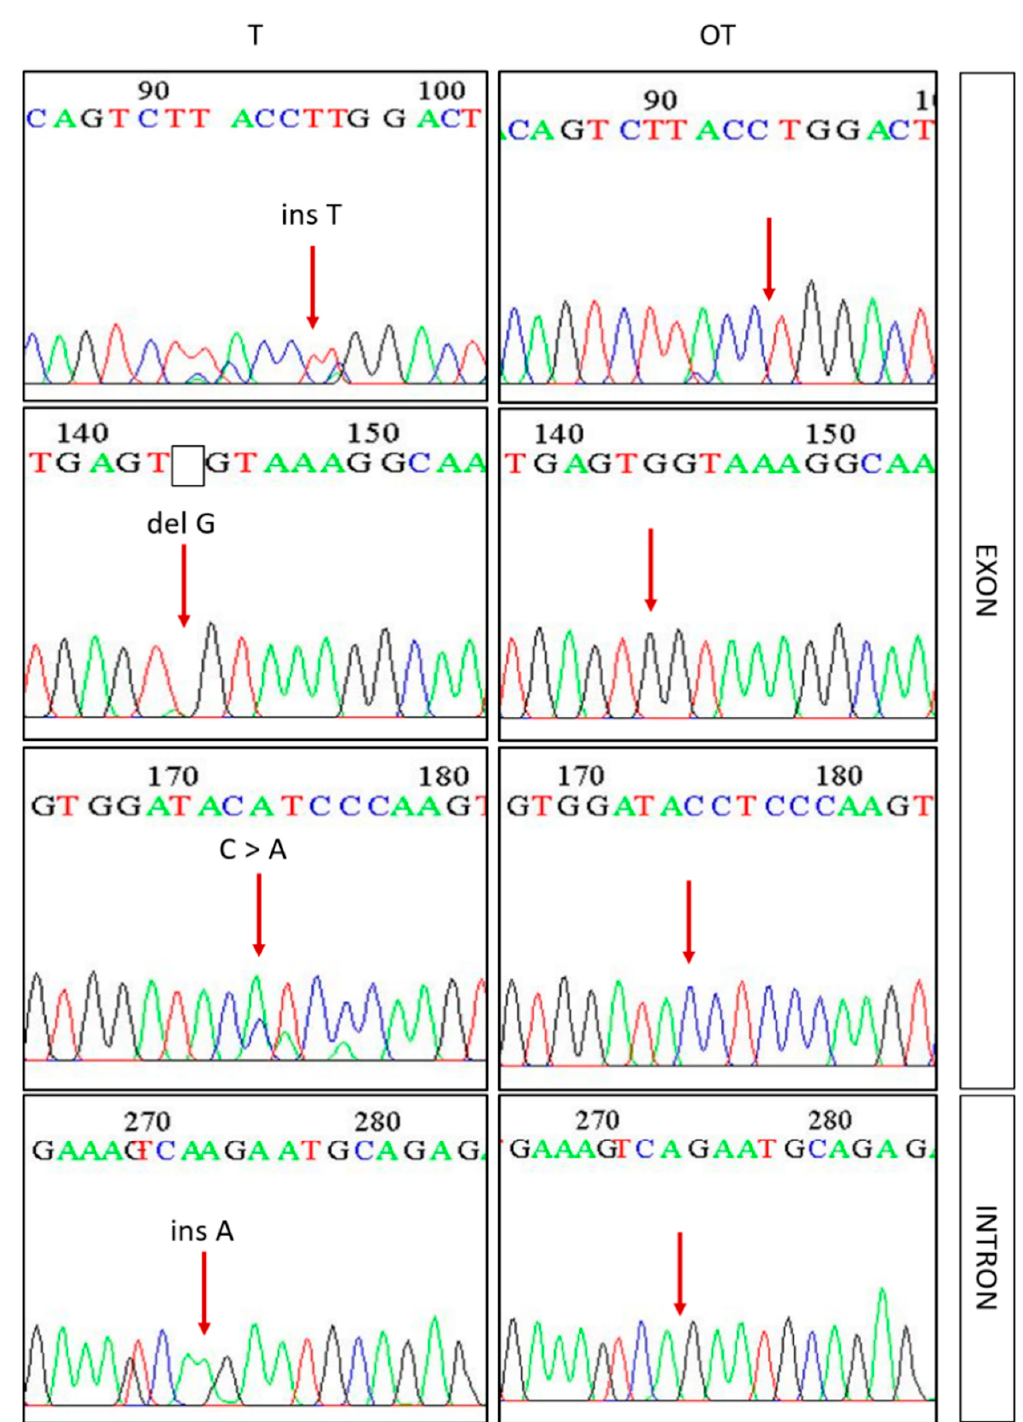
Figure 3. Examples of sequences with different types of mutations in exon 3 and intron 3 of the CTNNB1 gene obtained by the Sanger sequencing method. A red arrow indicates the location of the mutation. Legend: T—tumor sample, OT—blood sample of the same patient.